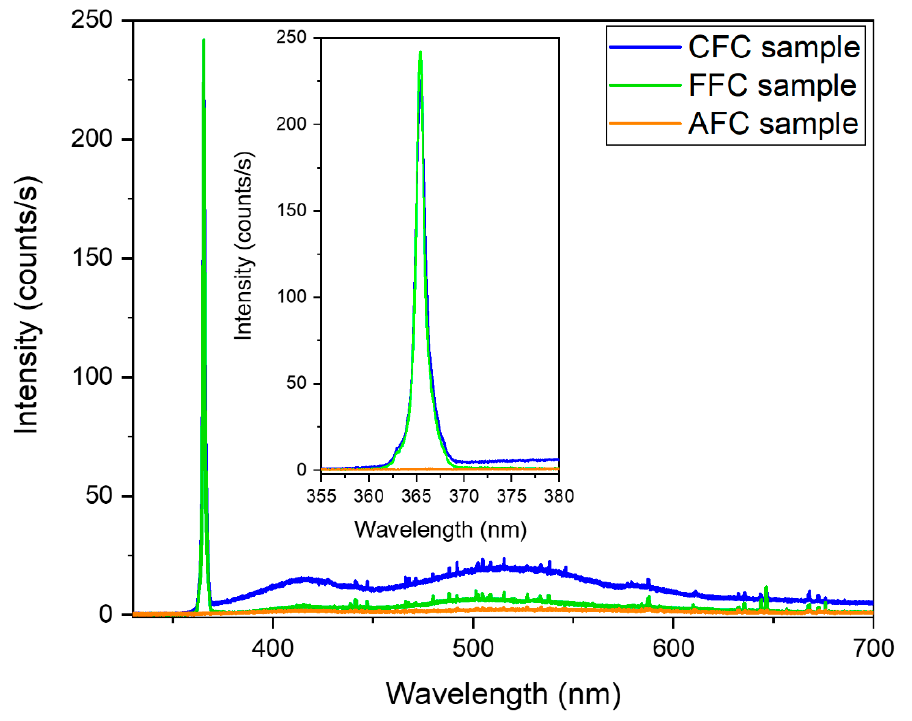
Figure 10. PL emission of CFC sample, FFC sample, and AFC sample (orange region) recorded using a 325 nm laser excitation wavelength. In the inset, a zoom of the peak at 365 nm is shown.